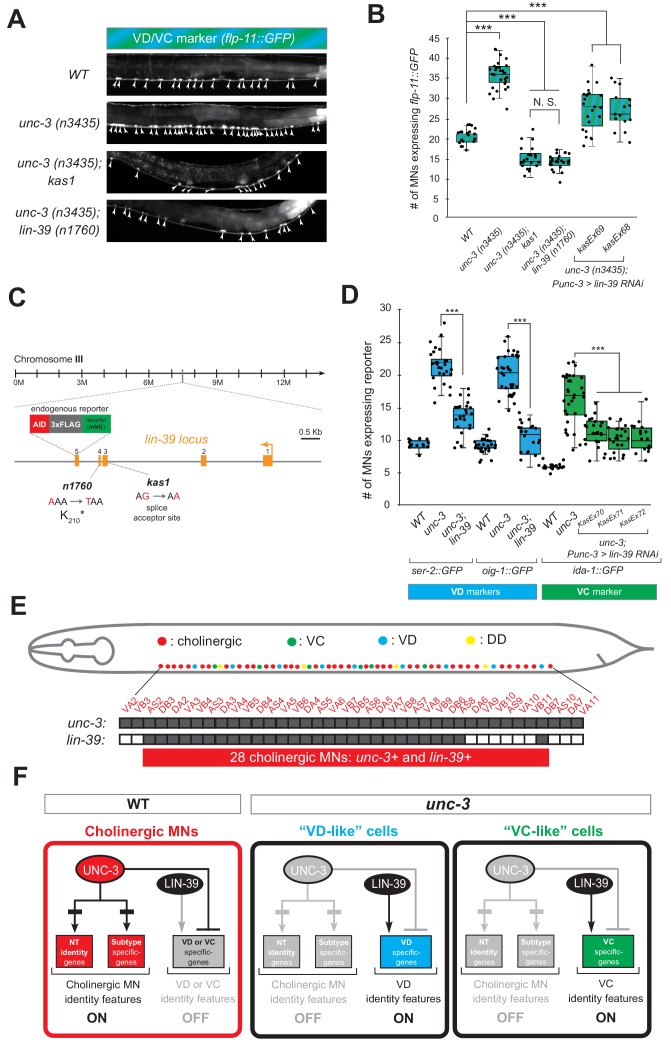
A genetic screen identifies the mid-body Hox protein LIN-39 (Scr/Dfd/Hox4-5) as necessary for ectopic expression of VD and VC terminal features.(A) Representative images of L4-stage WT, unc-3(n3435), unc-3(n3435); kas1, and unc-3(n3435); lin-39(n1760) animals carrying flp-11::gfp (VD/VC marker). Arrowheads point to MN cell bodies with gfp marker expression. (B) Quantification graph summarizing results from panel A. The two right-most bars show quantification of two independent transgenic lines driving lin-39 RNAi specifically in cholinergic MNs (Punc-3 >lin-39 RNAi) of unc-3 (n3435) mutants. N > 15. ***p<0.001. N.S: not significant. (C) Genetic locus of lin-39. Molecular lesions for kas1 and n1760 alleles are shown, as well as the AID::3xFLAG::mNG cassette inserted at the C-terminus (endogenous reporter). (D) Quantification of two VD (ser-2::gfp, oig-1::gfp) and one VC (ida-1::gfp) markers in WT, unc-3 (n3435), unc-3(n3435); lin-39(n1760) animals at L4. The three right-most bars show quantification of three independent transgenic lines driving lin-39 RNAi specifically in cholinergic MNs (Punc-3 >lin-39 RNAi) of unc-3 (n3435) mutants. N > 15. ***p<0.001. (E) Summary of unc-3 and lin-39 expression in cholinergic MNs. See Figure 4—figure supplement 2 for raw data. (F) Schematic that summarizes our findings. In the wild type (Faumont et al., 2011) panel on the left, lin-39 is normally expressed in cholinergic MNs but unable to induce expression of VD or VC genes. In the unc-3 mutant, lin-39 is now able to induce expression of alternative identity features (VD or VC) in distinct MN populations.